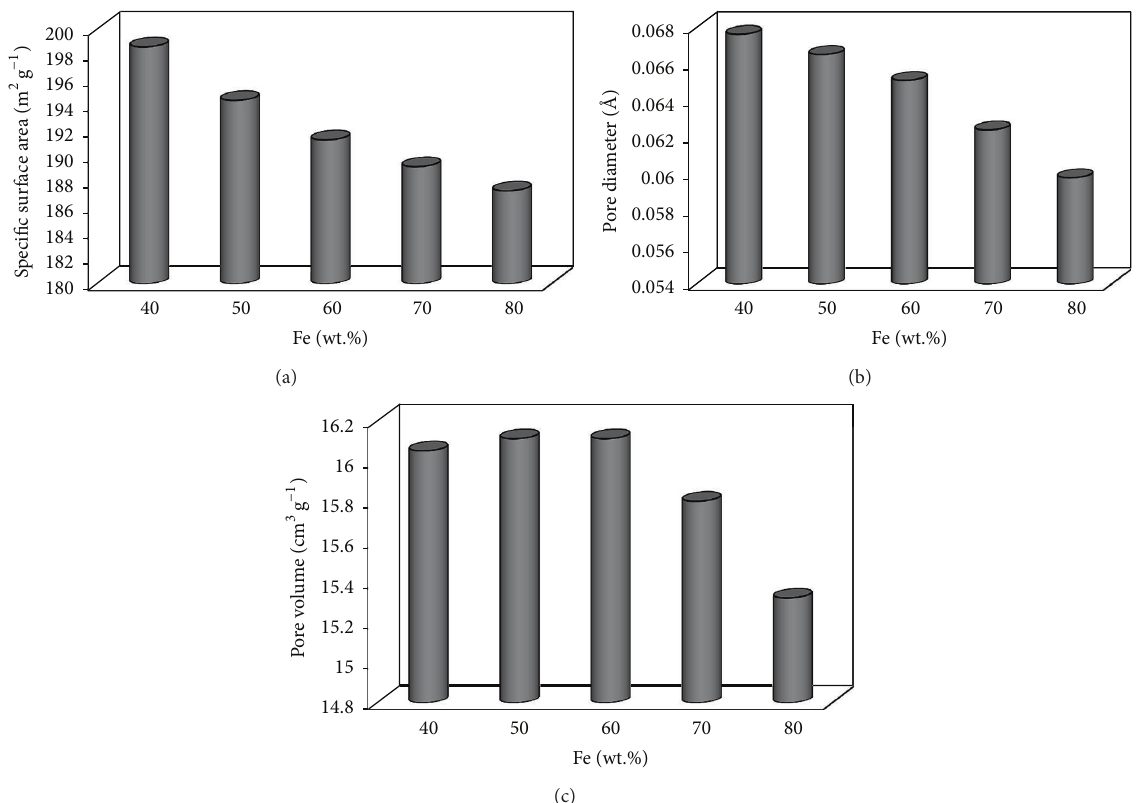
Figure 2: N 2 adsorption-desorption measurements of Fe/SiO 2 catalysts with different wt.% of Fe.